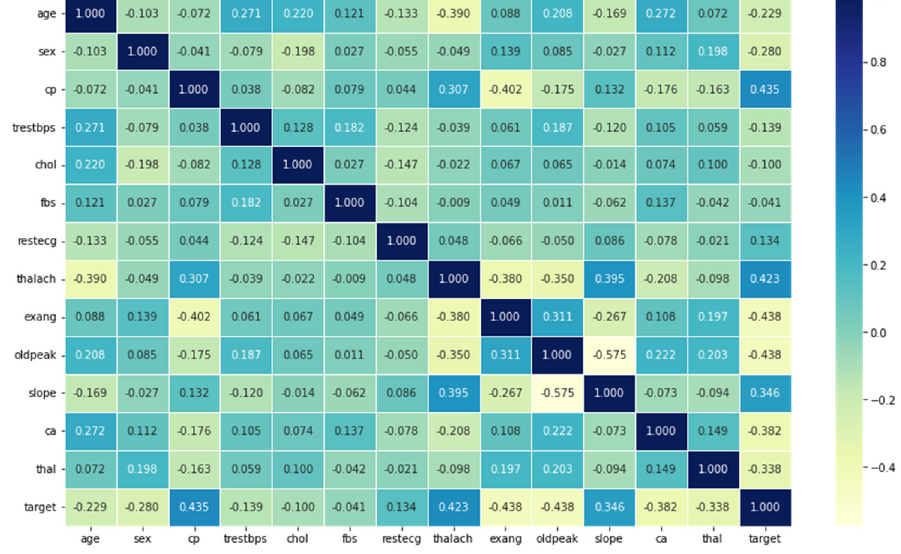
Figure 6. Correlation Map for Heart Disease .